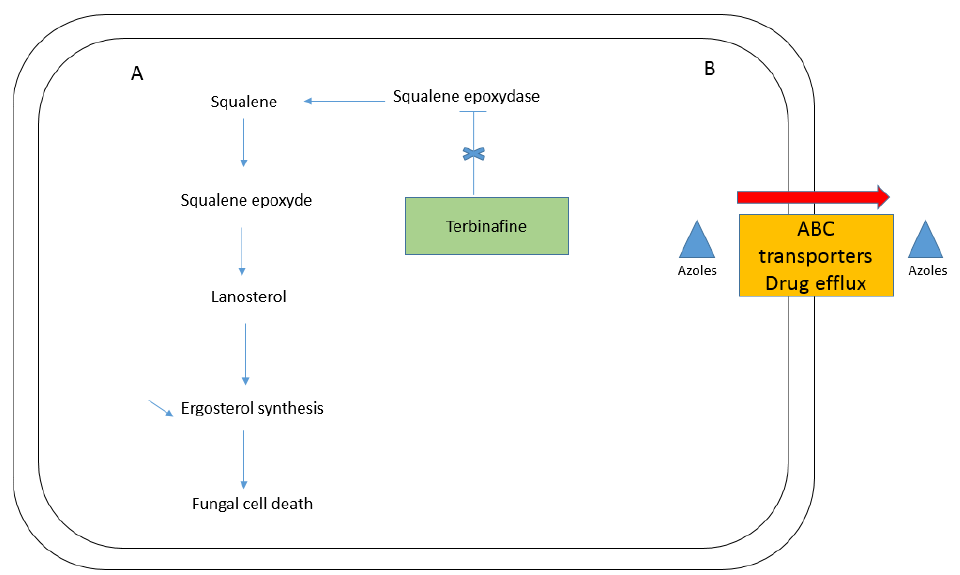
Figure 1 : The figure presents the main resistance mechanisms observed in dermatophytes. In A, a reduced sheme of the biosynthesis of ergosterol is represented. In case of mutations in squalene epoxydase gene, the terbinafine cannot inhibit the enzyme anymore, so there is no reduction of ergosterol synthesis and no cell death anymore (no fungicidal effect), giving rise to resistance. In B, the efflux mechanism by ABC transporters is mainly described for azoles resistance in